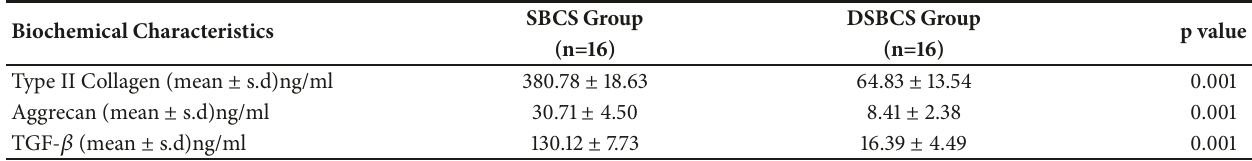
Table 3: Biochemical characteristics result in SBCS group and DSBCS group.